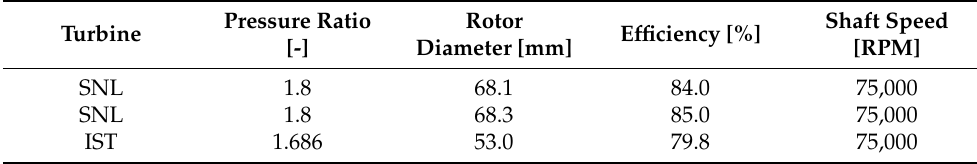
Table 4. S-CO 2 Turbine Experimental Facility Design Values [24,26].